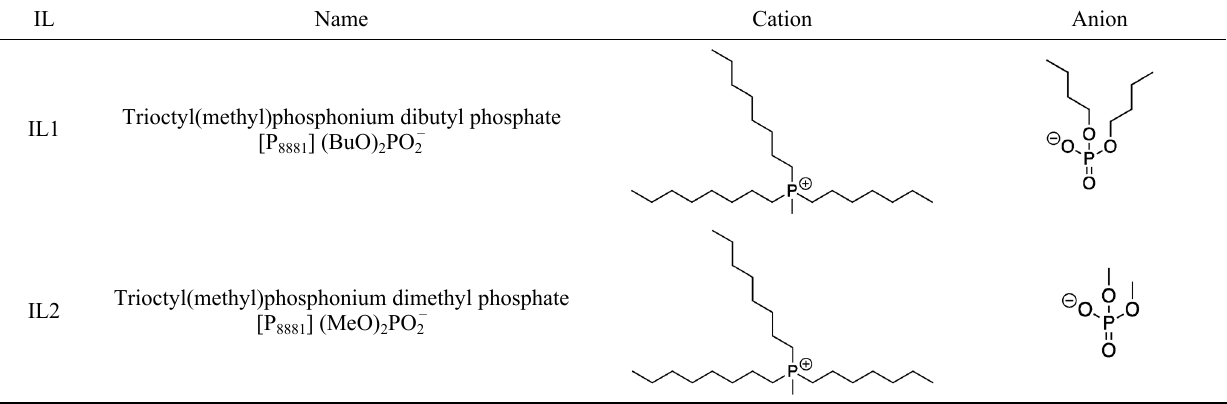
Table 1 Molecular name and structure of the two ILs. IL Name Cation Anion